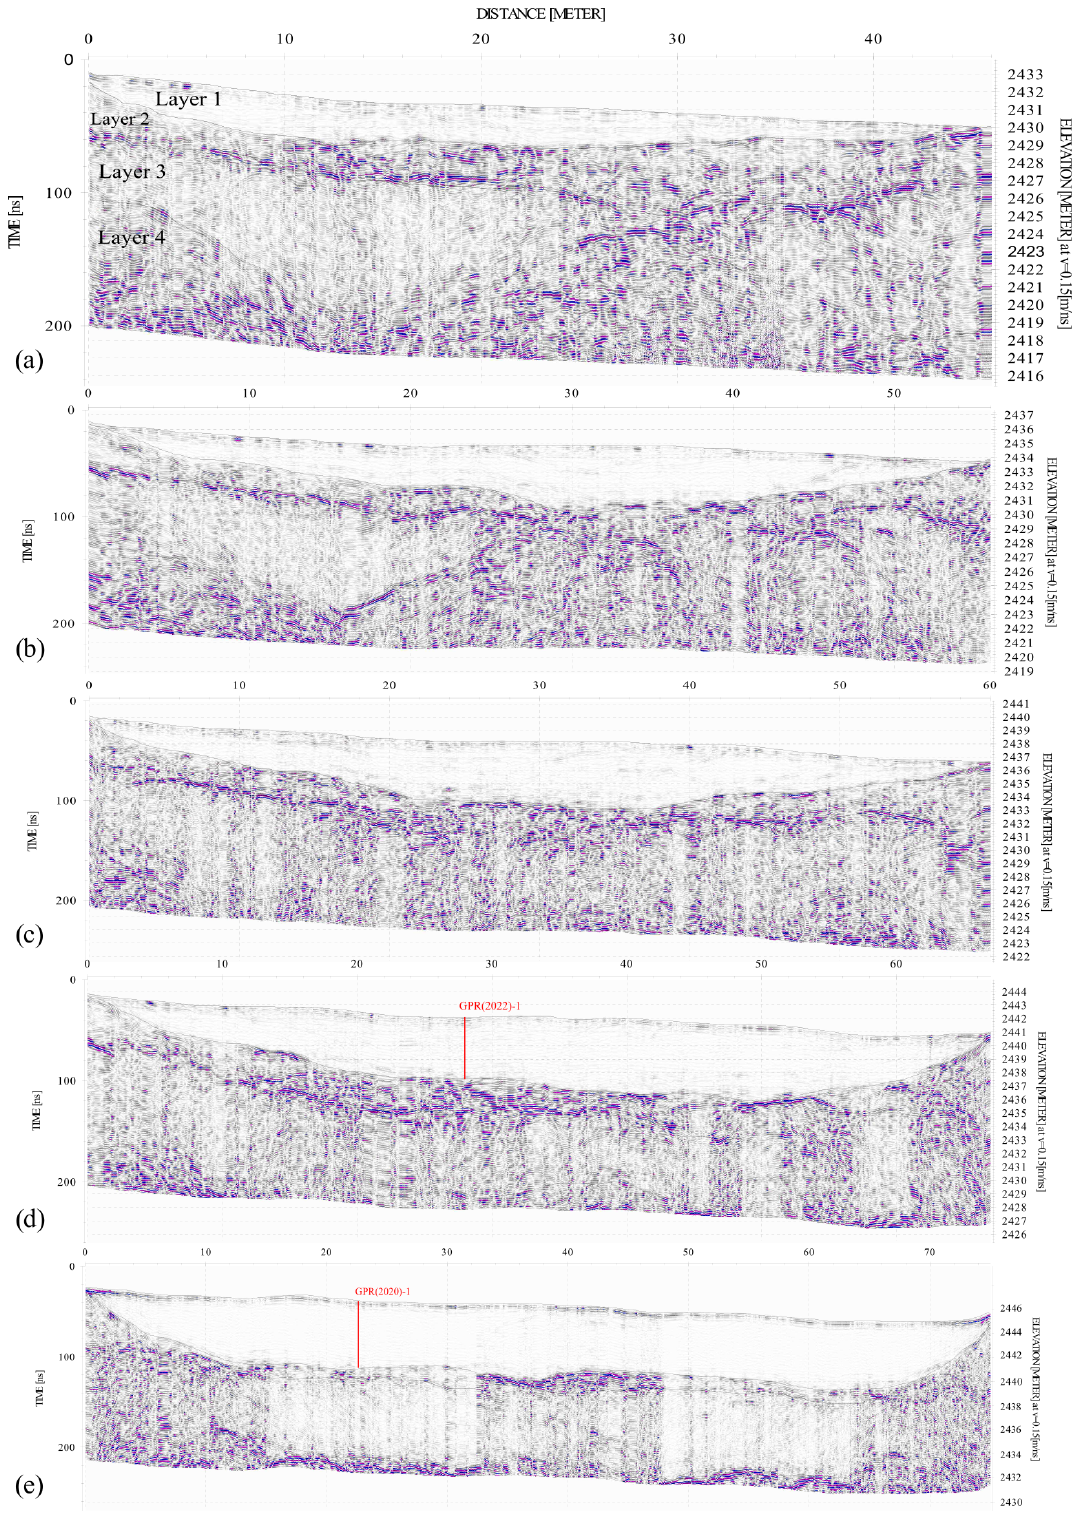
Figure 4. GPR profiles from 2018: (a) GPR(2018)-1 situated at the lowest altitude; (b) GPR(2018)-2; (c) GPR(2018)-3; (d) GPR(2018)-4; (e) GPR(2018)-5 situated at the highest altitude. All profiles are with horizontal elevation. Red lines indicate the point of intersection with GPR(2020)-1.